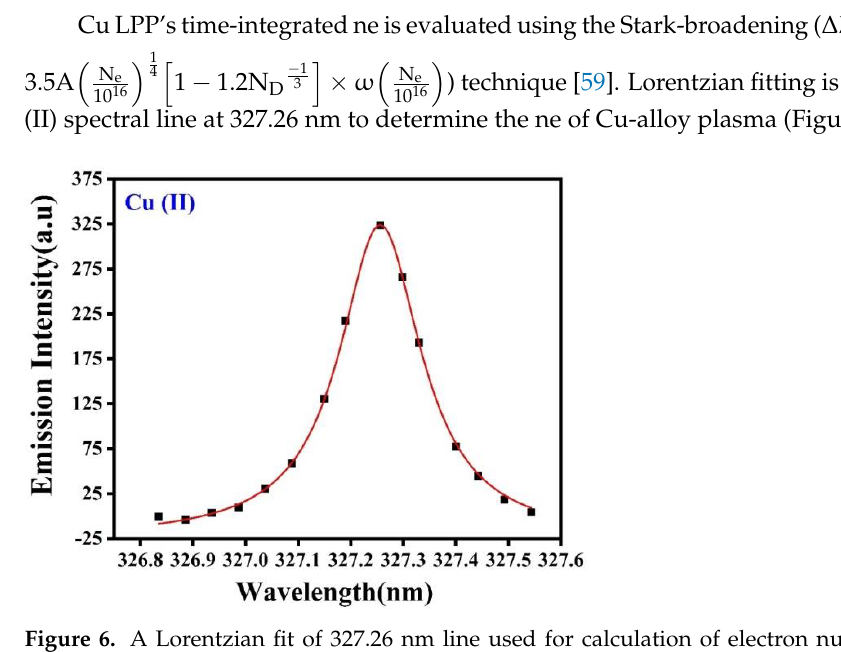
0.81 × 10 18 cm − 3 to 1.58 × 10 18 cm − 3 for Ne, and 0.69 × 10 18 cm − 3 to 1.41 × 10 18 cm − 3